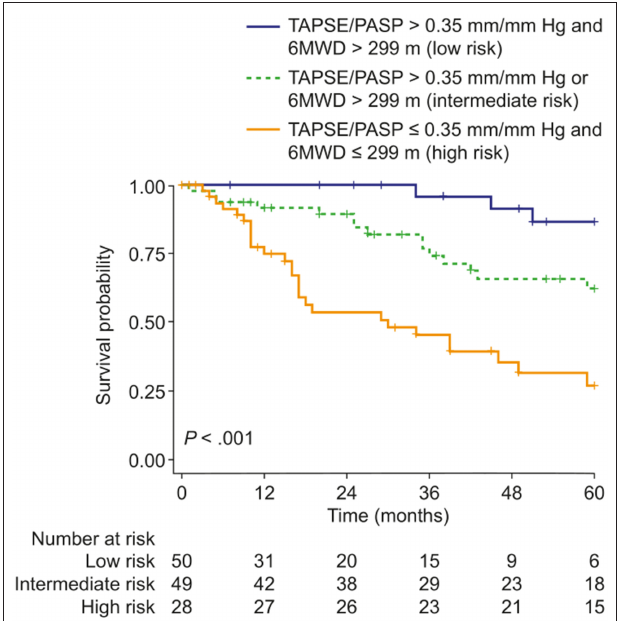
FIGURE 1 | Kaplan–Meier curves of survival probability in patients with pulmonary hypertension due to COPD stratified according to the presence/absence of two risk factors: 6MWD ≤ 299m and/or TAPSE/PASP ratio ≤ 0.35 mm/mm Hg (thresholds determined by receiver operating characteristic analysis and Youden’s index). 6MWD, 6-min walk distance; TAPSE/PASP, tricuspid annular plane systolic excursion/pulmonary artery systolic